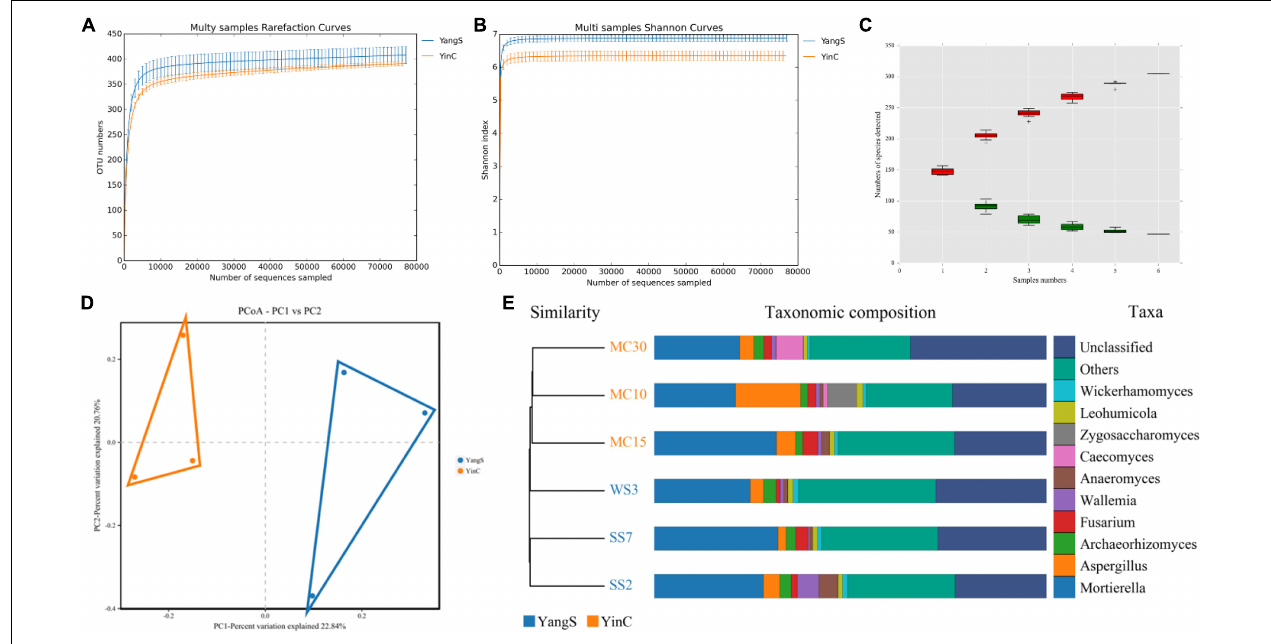
FIGURE 2 | Analysis of samples feasibility and fungal OTUs structures in different groups. (A) Rarefaction curves; (B) shannon curves; (C) species accumulation curves; (D,E) fungal PCoA scatterplot and UPGMA clustering tree to reflect similarity between the individuals or groups.